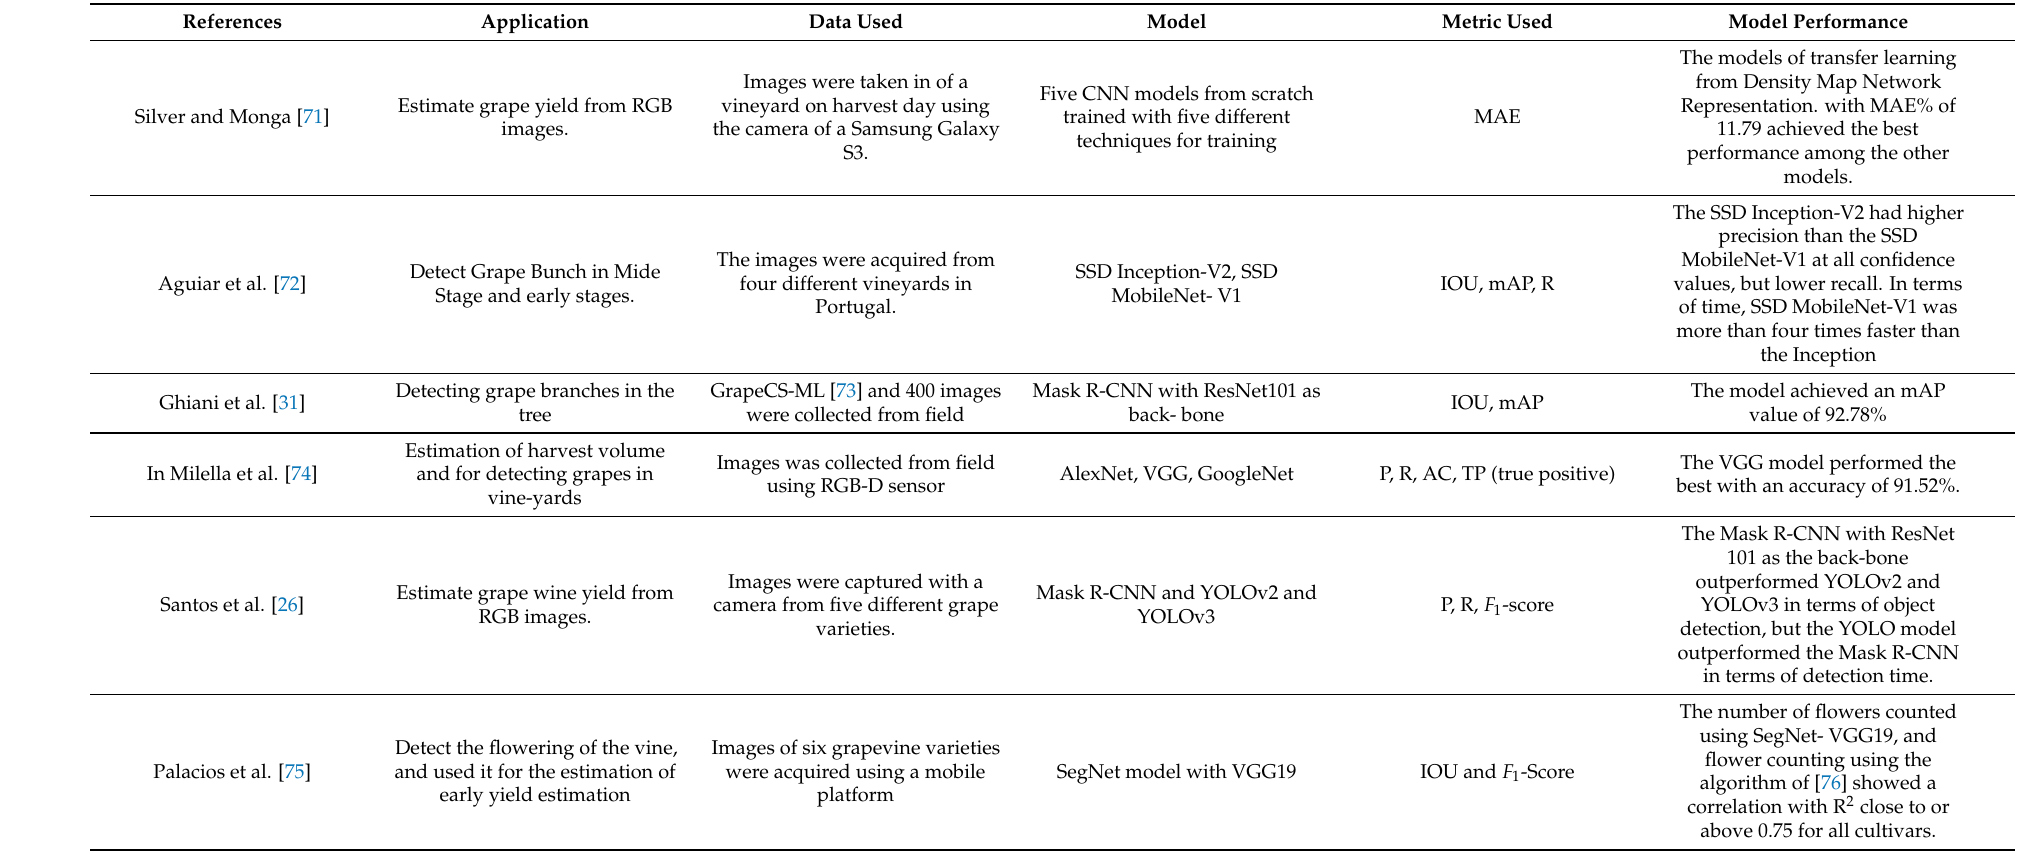
Table 3. Feature descriptions of recent published papers in the field of “Fruit detection and Yield